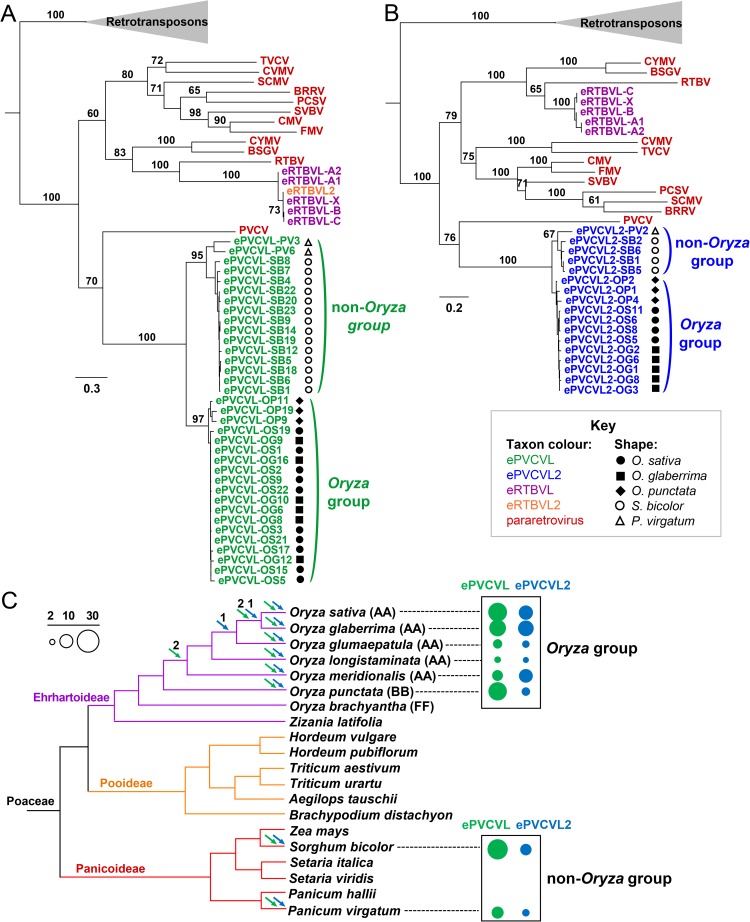
Phylogenetic relationships and distribution patterns of ePVCVL and ePVCVL2 sequences in grass genomes.(A) Phylogenetic relationships of ePVCVL sequences and extant PRVs based on the CP domain (alignment length = 439 amino acids). (B) Phylogenetic relationships of ePVCVL2 sequences and extant PRVs based on the RT/RH domain (alignment length = 415 amino acids). ML trees were constructed based on amino acid alignments. Highly truncated sequences were not included in the phylogenetic analysis. The trees are midpoint-rooted for display purposes. Bootstrap support percentages greater than 60% based on 1,000 replicates are shown above branches for major nodes. Consensus sequences of eRTBVL and eRTBVL2 were also included in the analyses. Sequences of Ty3/Gypsy LTR retrotransposons were used as outgroups. Scale bars represent genetic distances in terms of substitutions per site. Sequences of ePVCVL, ePVCVL2, eRTBVL, eRTBVL2, and extant pararetroviruses are indicated by green, blue, purple, orange, and red, respectively. The grass genome harboring each ePVCVL or ePVCVL2 sequence is represented by the indicated symbols. Detailed information on ePVCVL and ePVCVL2 sequences is available in S3 Table. CYMV, commelina yellow mottle virus; BSGV, banana streak GF virus; RTBV, rice tungro bacilliform virus; TVCV, tobacco vein clearing virus; CVMV, cassava vein mosaic virus; SCMV, soybean chlorotic mottle virus; BRRV, blueberry red ringspot virus; PCSV, peanut chlorotic streak virus; SVBV, strawberry vein banding virus; CMV, cauliflower mosaic virus; FMV, figwort mosaic virus; PVCV, petunia vein clearing virus. GenBank numbers of these sequences are available in S3 Dataset. (C) Endogenization and distribution of ePVCVL and ePVCVL2 in grass genomes. The phylogenetic tree of grass species was drawn according to information in references [63, 79]. Purple, orange, and red branches indicate Ehrhartoideae, Pooideae, and Panicoideae subfamily species, respectively. AA-, BB-, and FF-genome groups of the genus Oryza are noted in parentheses. Arrows above branches represent endogenization events in which ePVCVL (green) and ePVCVL2 (blue) segments were integrated into the corresponding grass genomes. Numerals above arrows are the number of shared ePVCVL/ePVCVL2 segments endogenized at different time points. The sizes of solid circles correspond to the number of ePVCVL (green) and ePVCVL2 (blue) segments in the different grass genomes according to the scale in the upper left hand corner.